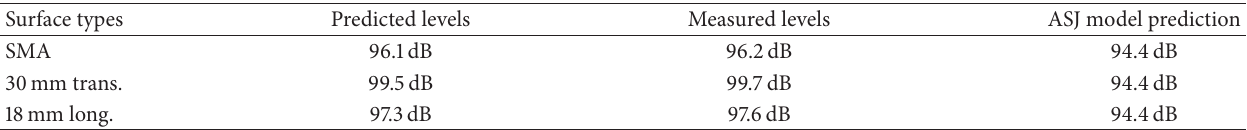
Table 7: Comparison of predicted and measured traffic noise